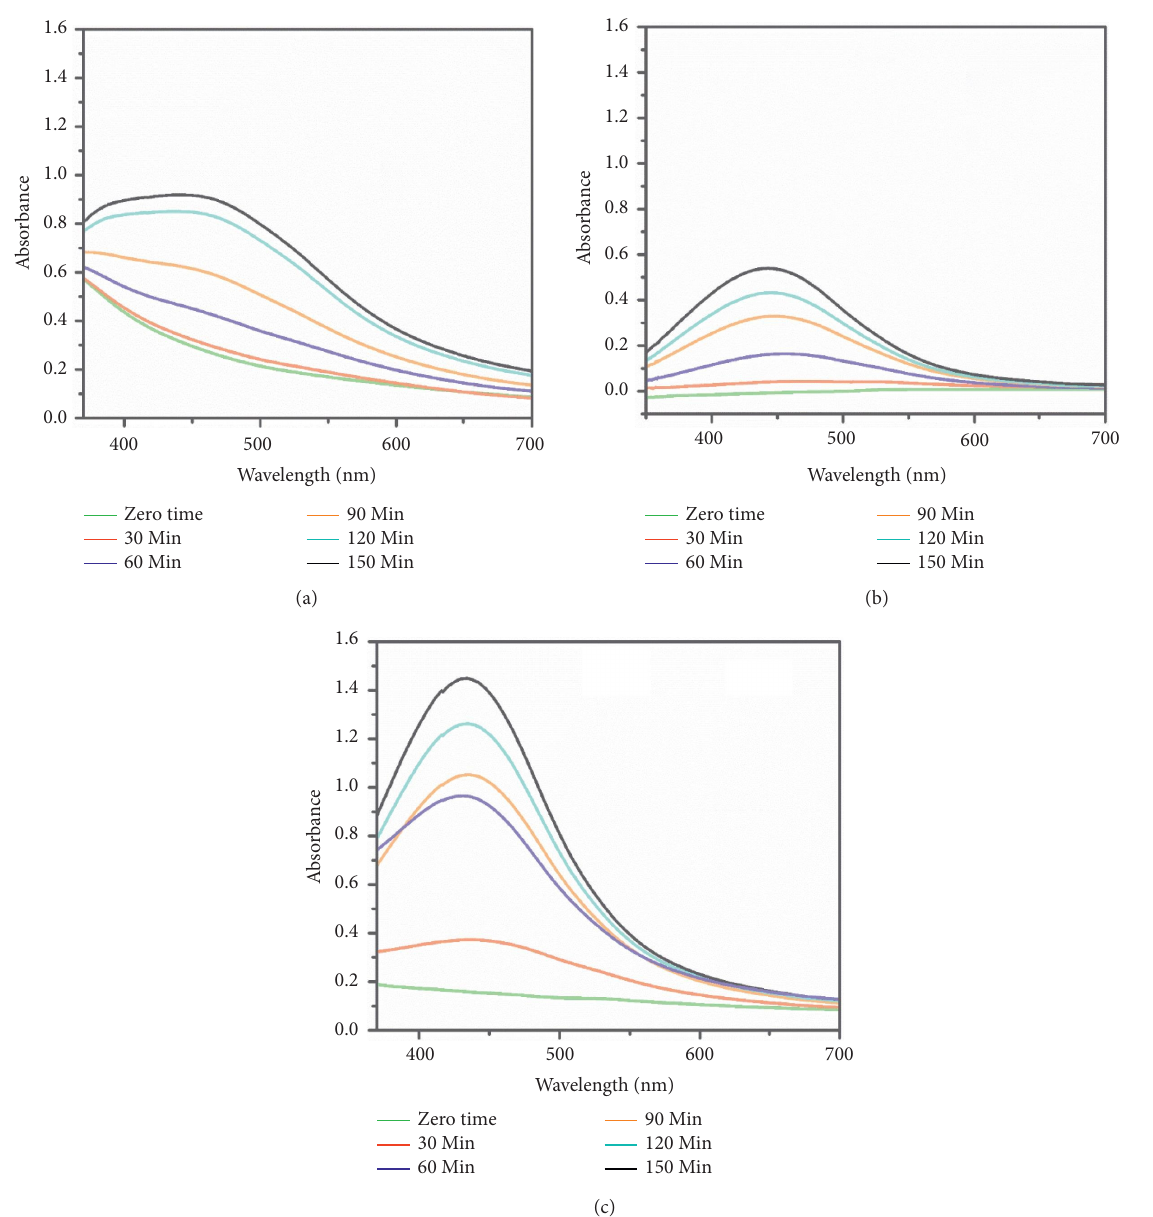
Figure 1: UV-vis absorption spectra of the silver nanoparticles biosynthesized by Cystoseira myrica at different pH; (a) pH � 5, (b) pH � 7, and (c) pH � 9 at different time intervals minutes (zero time, 30, 60, 90, 120, and